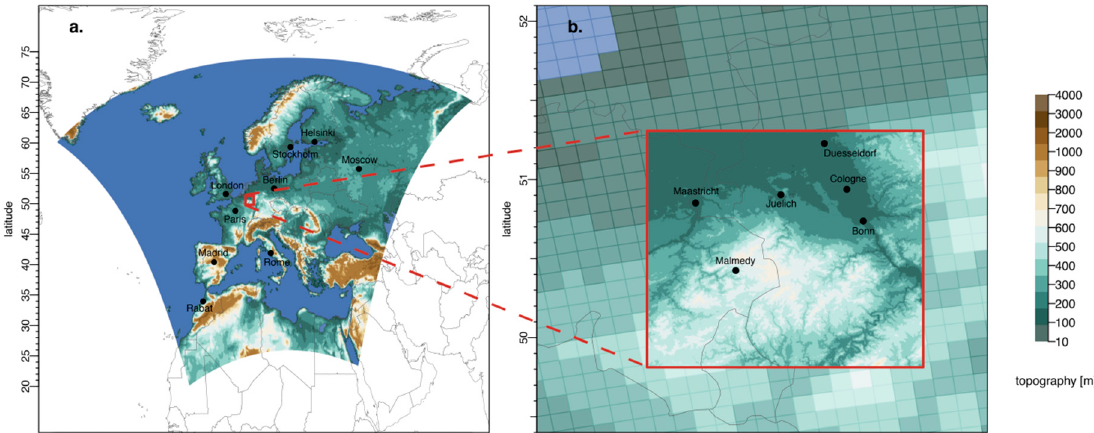
Figure 1. The monitoring domains, Europe (EU, left) and North Rhine-Westphalia (NRW, right). Black circles indicate capitals and major cities of the simulation domains. The domain highlighted in red in the figure on the right is the NRW domain, which is highly equipped with hydrological and hydrometeorological measurement equipment. The resolution differences in ( b ) illustrate the different grid cell sizes of the model setups, i.e., 12.5 km for the EU domain and 500 m for the NRW domain.